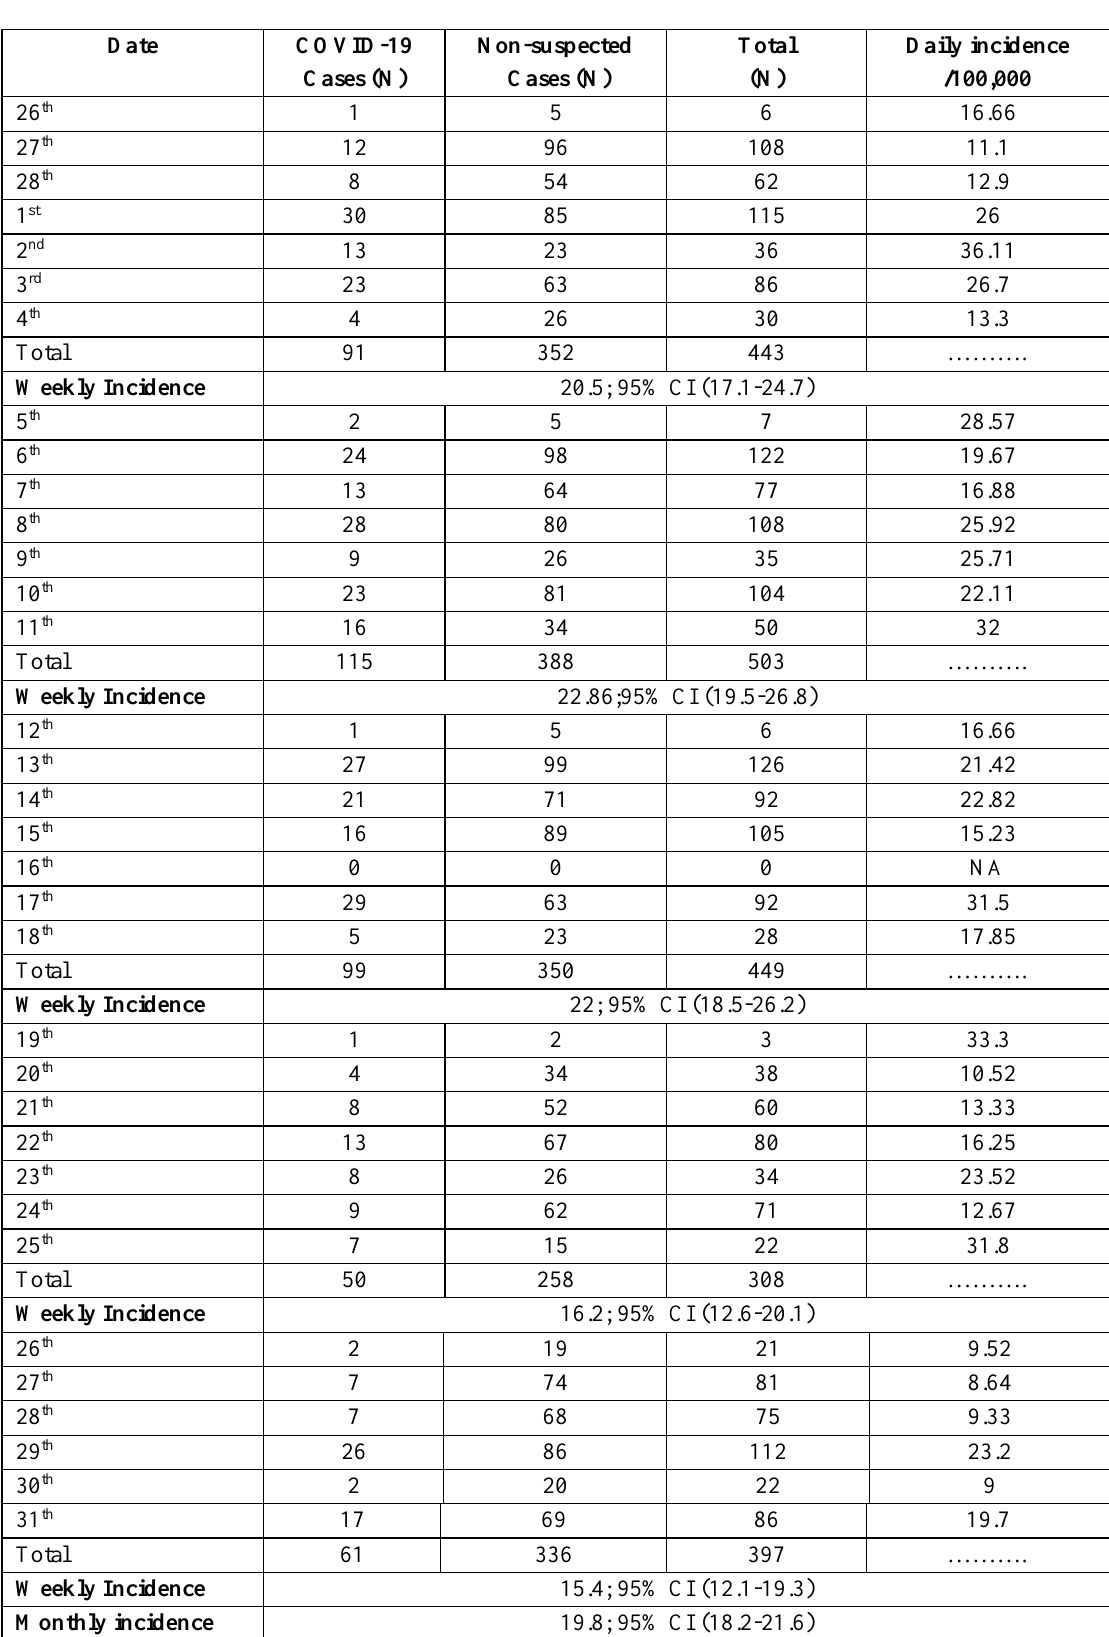
Table 3. Incidence of moderate and severe COVID-19 at ZUH during March